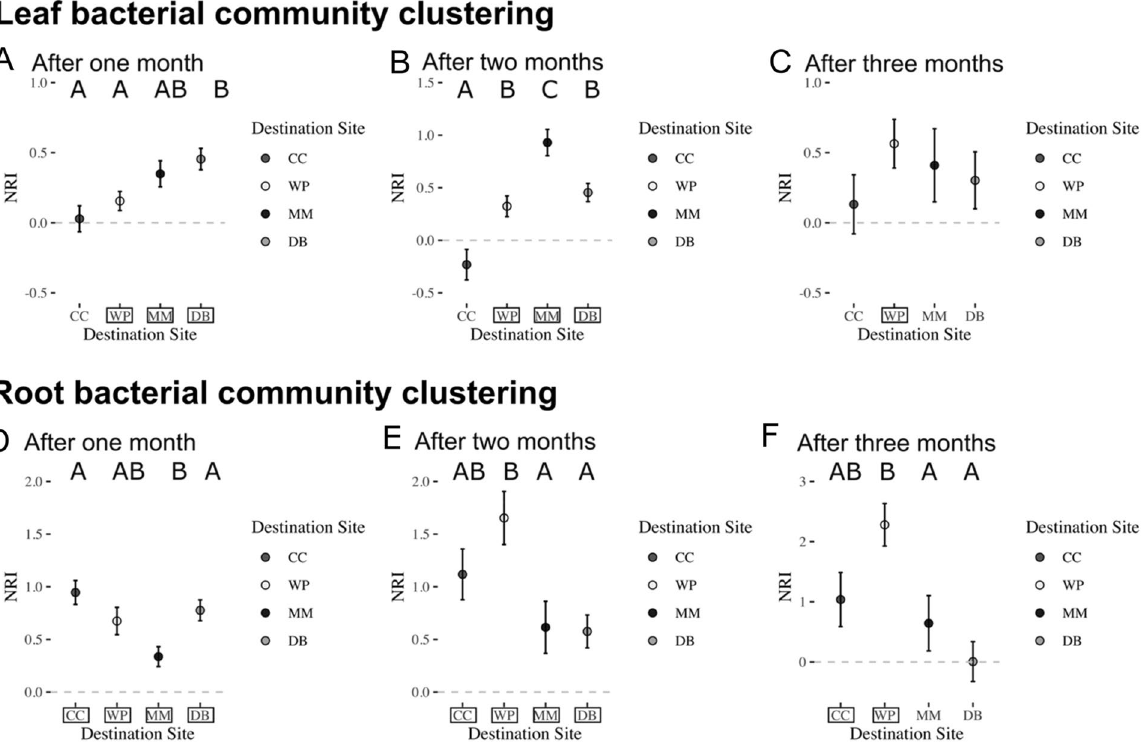
Figure 5. Leaf microbial communities were often phylogenetically clustered as measured by Net Relatedness Index (NRI) (mean + /- SE) by destination site after one (A), two (B), and three (C) months. Destination sites are indicated by abbreviation and colors indicated on the figure. A positive NRI indicates that communities at a site are phylogenetically clustered, a negative NRI indicates that a community is phylogenetically overdispersed. If a community’s NRI is significantly different from zero, we placed a box around the site name (see Supplemental Table S9 for more detailed statistics). Root microbial communities were consistently phylogenetically clustered as measured by Net Relatedness Index (NRI) (mean + /- SE) is shown by destination site after one (D), two (E), and three (F)